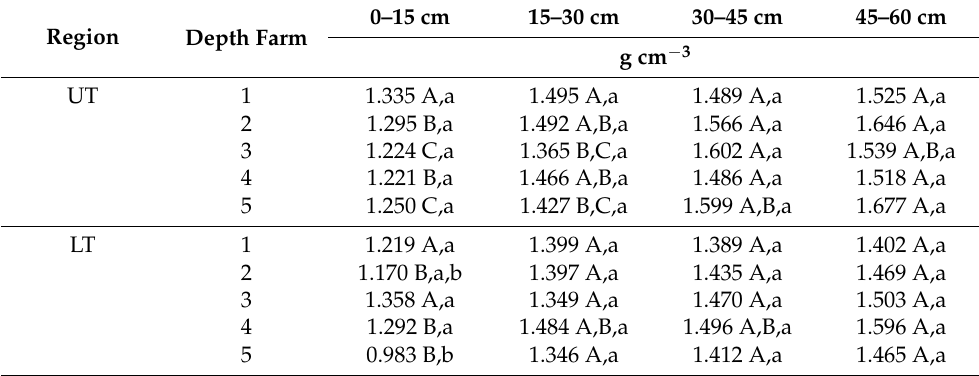
Figure 7. Effects of different farm management ( a , b ) and soil depth ( c , d ) on PMN content ( a , c ) and stocks ( b , d ) under mixed pastures in the Tsitsikamma dairy farms. Error bars indicate standard error of means. Different letters per site indicate significant difference. PMN, potentially mineralizable nitrogen. Table 5. Changes in bulk density as influenced by farm × depth interactions under mixed pastures in the Upper (UT) and Lower (LT) Tsitsikamma dairy